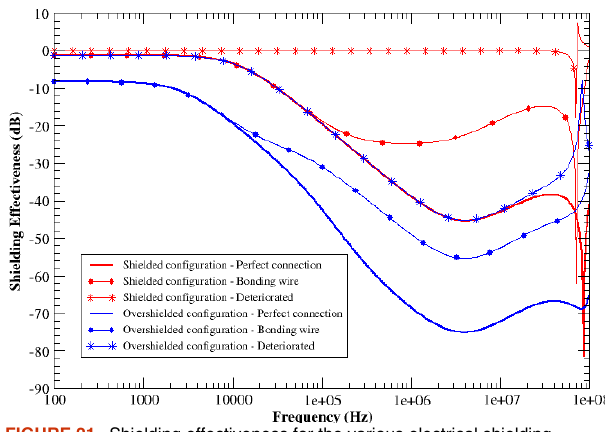
FIGURE 21. Shielding effectiveness for the various electrical shielding solutions of W 2 (CRIPTE